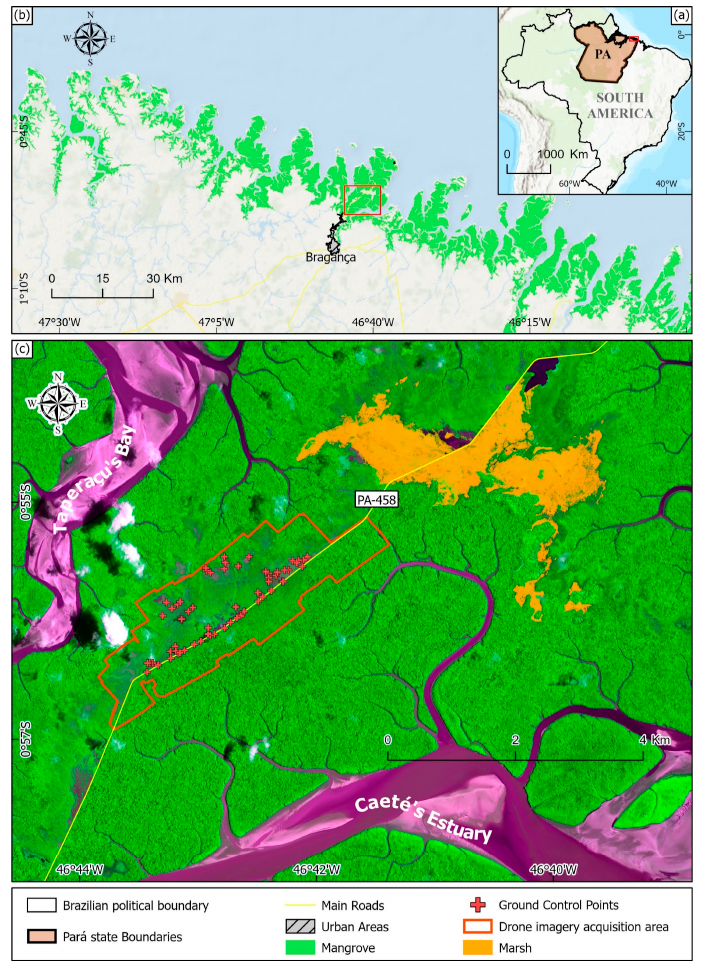
Figure 1. Study area: ( a ) Location of the study area in South America; ( b ) Mangrove coverage in the Amazon Macrotidal Mangrove Coast; ( c ) Positions of Ground Control Points (GCPs) along the road and degraded mangrove, and drone imagery acquisition in the study area.